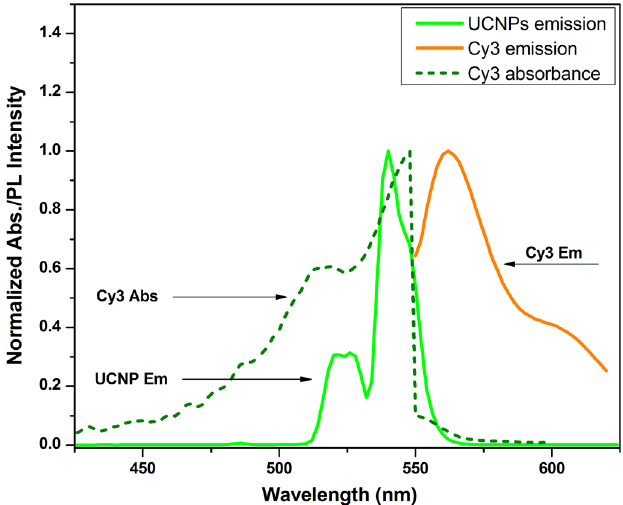
Figure 2. Normalized absorption (dashed lines) and emission spectra (solid lines) for the UCNP-Cy3 LRET pairs. Dashed grey line: Cy3 absorbance spectrum, absorbance peak: 548 nm; solid grey line: Cy3 emission spectrum, emission peak: 562 nm; solid dark line: UCNP emission spectrum, emission peak: 540 nm. The green area indicates the spectrum overlap between Cy3 absorbance and UCNP emission, and the yellow region indicates the Cy3 emission